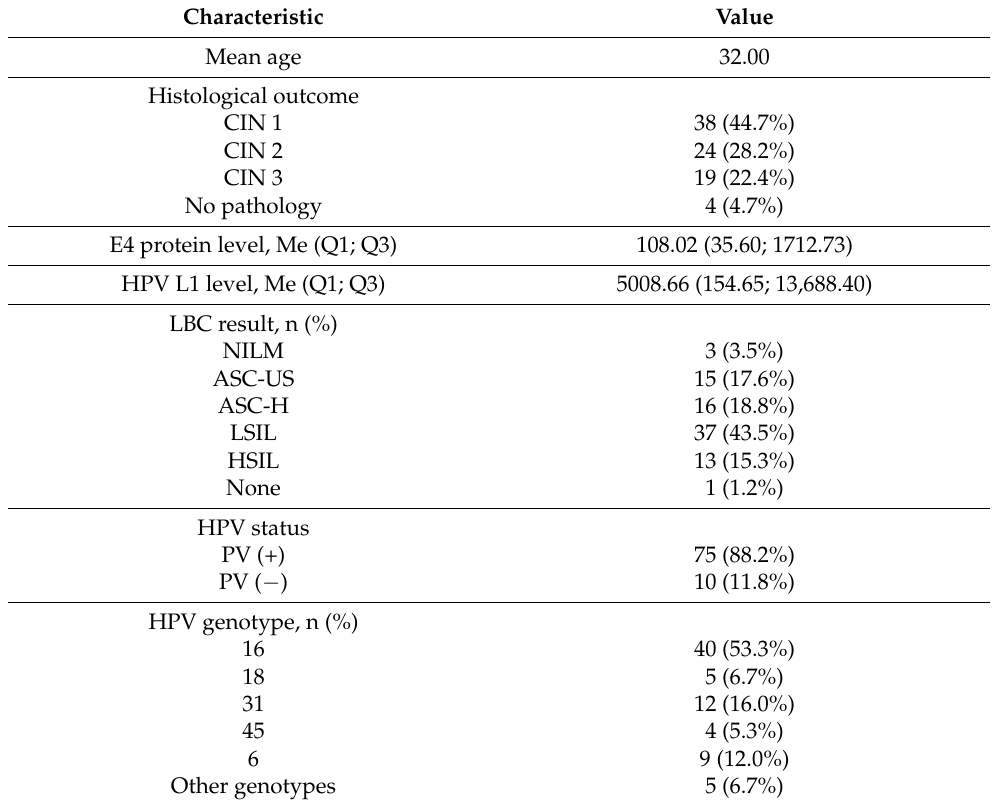
Table 1. Characteristics of the study group including the age of patients, level of cervical intraepithe- lial neoplasia, results of LBC, and HPV status with the genotype of the virus. Characteristic Value Mean age 32.00 Histological outcome CIN